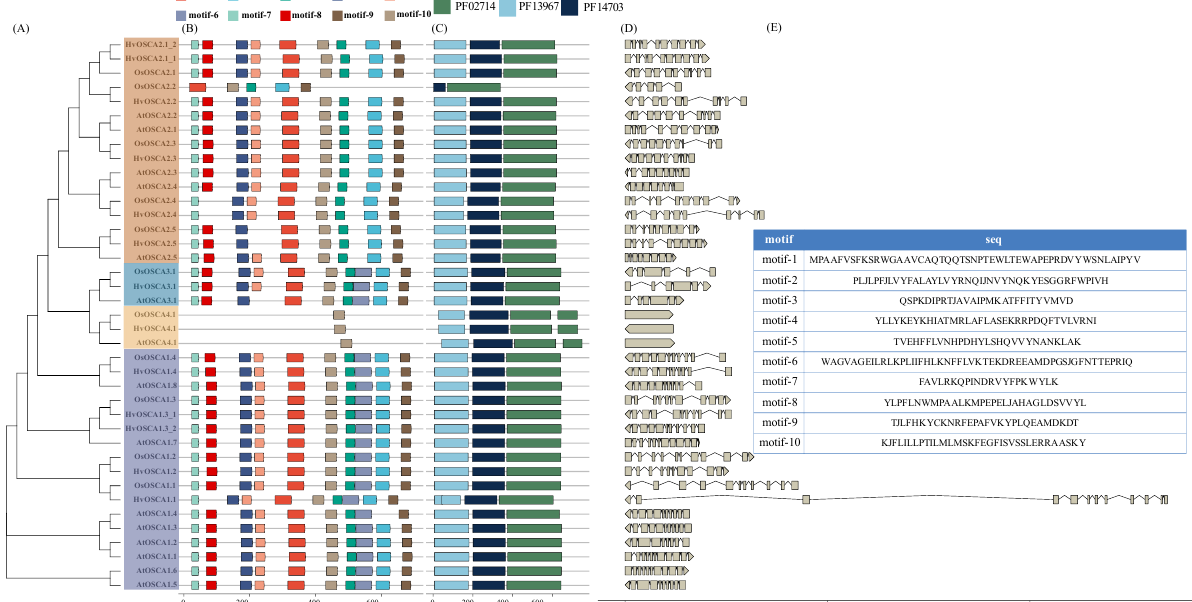
Figure 2. Motif composition, conserved domain and gene structure analysis of HvOSCA s. ( A ) Phylo- genetic relationship of HvOSCAs , members of different clades were marked in different background colors. ( B ) Functional motif compositions of these 13 HvOSCAs. Ten motifs were represented by rectangle box in different colors. ( C ) The function conserved domain of PFAM02714, PFAM13967 and PFAM14703 organization in HvOSCAs , represented by dark blue, dark turquoise boxes and purplish blue, respectively. ( D ) Intron-exon organizations of HvOSCAs . The introns and exons are represented by the broken line and gray boxes, respectively. ( E ) The protein sequence of the 10 identified